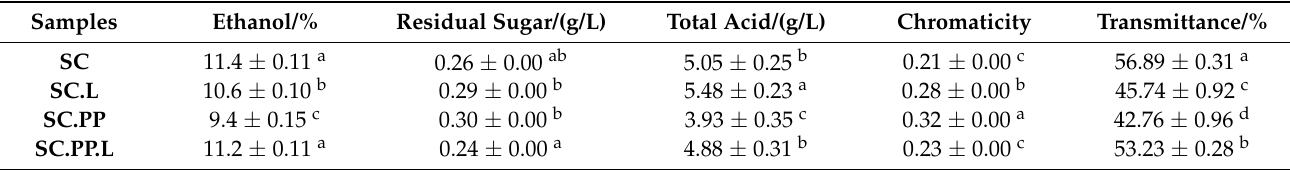
Table 2. Physicochemical properties of fermentation